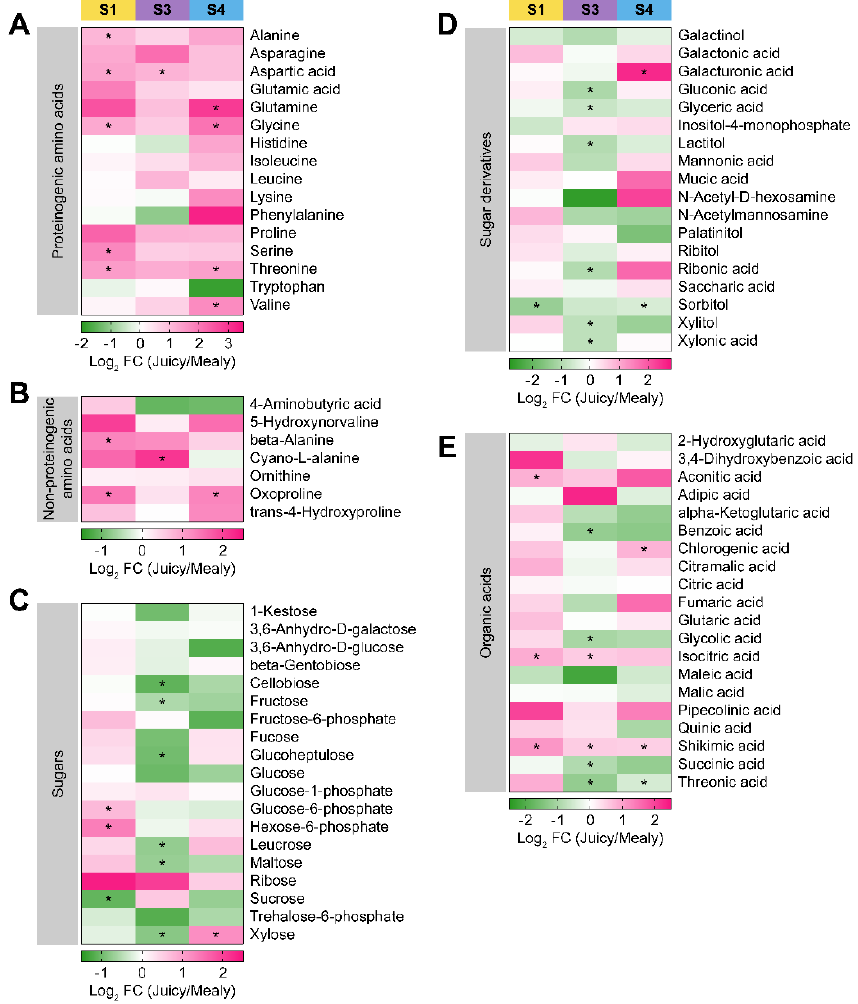
Figure 5. Accumulation of metabolites across nectarine ripening during cold storage. Log 2 fold change of relative intensity of metabolites from juicy variety over mealy variety in S1, S3, and S4 stages. ( A ) Proteinogenic amino acids, ( B ) non-proteinogenic amino acids, ( C ) sugars, ( D ) sugar derivatives, and ( E ) organic acids. Data were tested by a t -test (* p < 0.05) comparing mealy and juicy varieties consisting of three biological replicates ( n = 3).